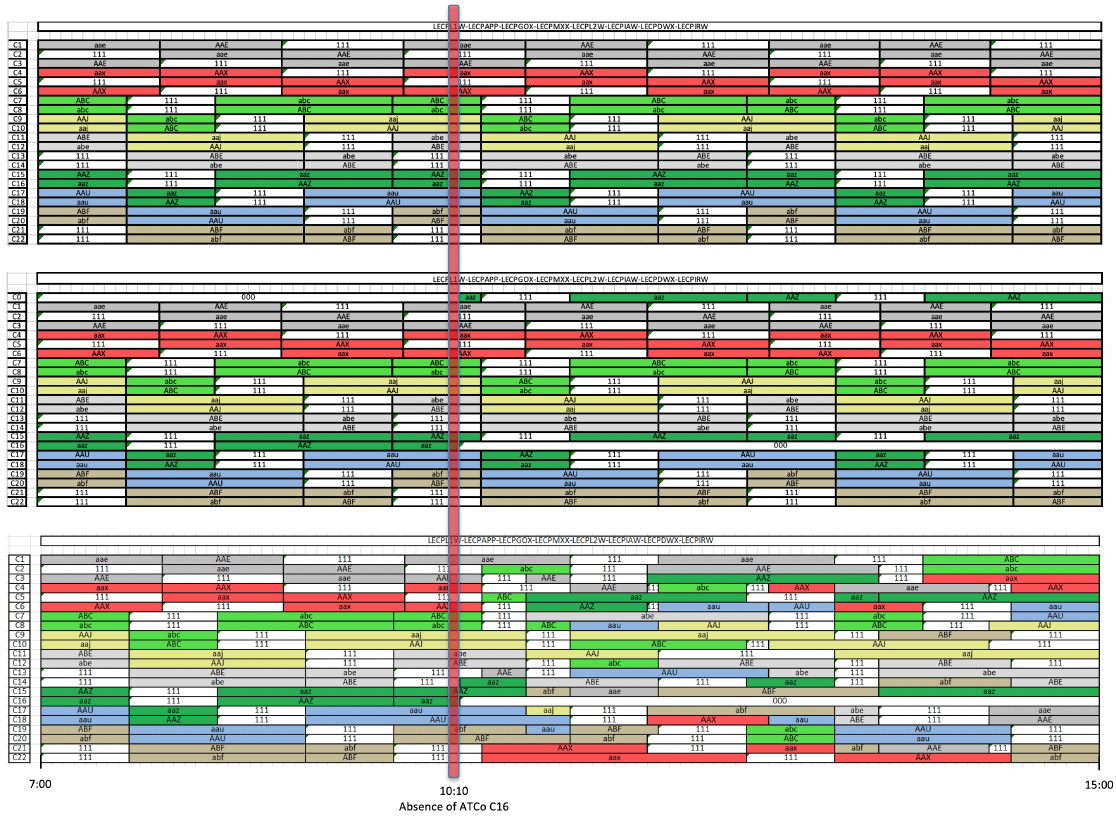
Figure 17. Solution before the incident, solution derived in Phase 1 and solution for Instance